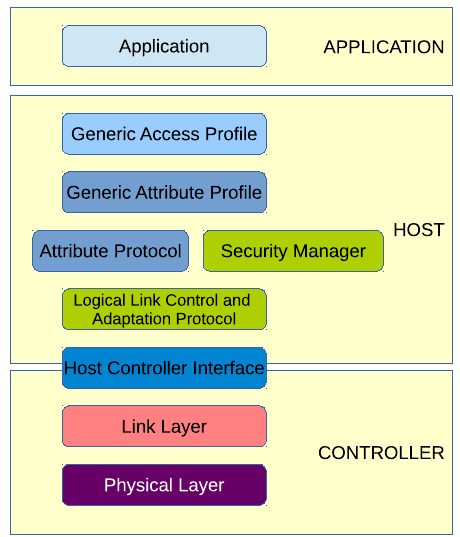
Figure 1. The Generic Access Profile (GAP) layer within the BLE protocol stack.